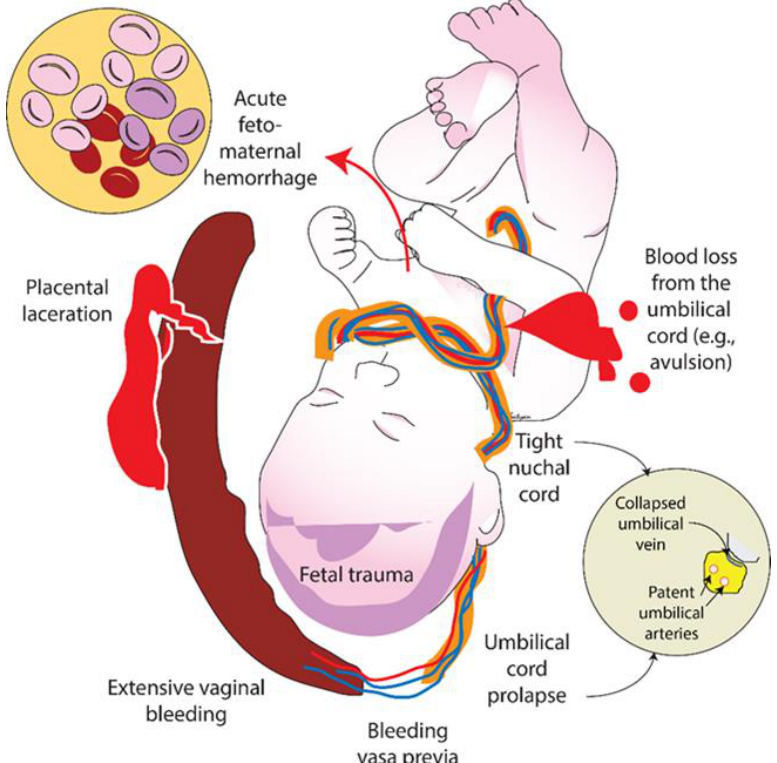
Figure 1. Acute blood loss may be secondary to various causes listed in the illustration. In infants born through a tight nuchal cord, there may be partial umbilical cord occlusion compressing the collapsible umbilical vein decreasing blood flow into the fetus but allowing blood flow out of the fetus into the placenta through the umbilical arteries (inset). Copyright Satyan Lakshminrusimha.